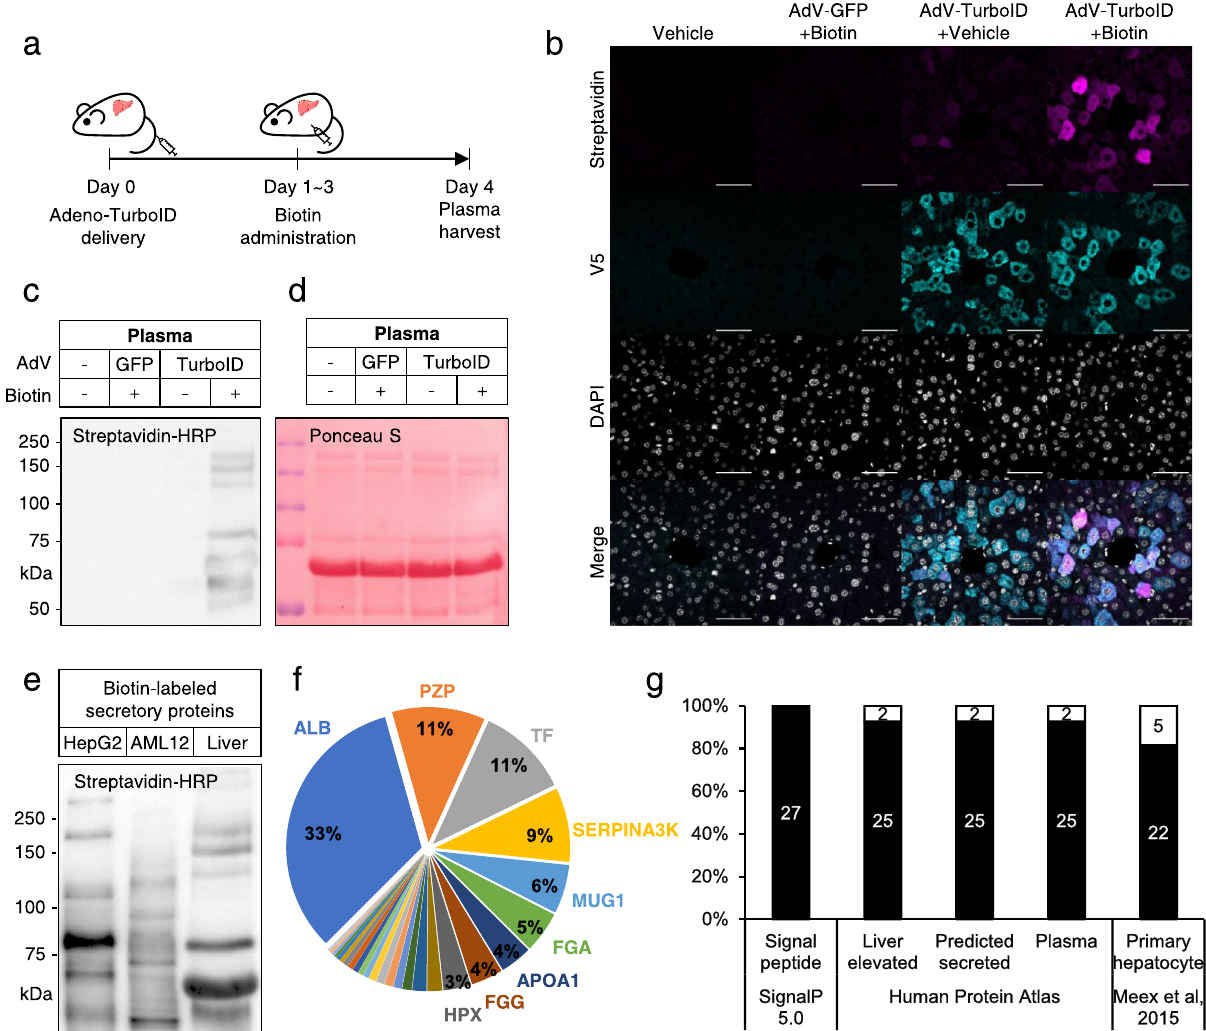
Fig. 3 Identi fi cation of liver-speci fi c secretory proteins in plasma from liver i SLET mice. a Experimental scheme for adenoviral expression of Sec61b-V5- TurboID and biotin labeling in mouse liver tissue. b Immuno fl uorescence imaging of TurboID (Anti-V5) and biotinylated proteins (Streptavidin-Alexa) in liver tissue sections from GFP or Sec61b-V5-TurboID adenovirus (AdV) transduced mice. Scale bars, 50 μ m. These experiments were repeated as biological triplicates with similar results. c , d Streptavidin-HRP detection of biotinylated proteins ( c ) and Ponceau S staining of proteins ( d ) in blood plasma from GFP or Sec61b-V5-TurboID adenovirus (AdV) transduced mice. These experiments were repeated as biological triplicates with similar results. e Biotinylated secretory protein pro fi les generated by Sec61b-V5-TurboID adenovirus in supernatants of hepatocyte cell lines, HepG2 and AML12, and plasma of liver i SLET mice. These experiments were repeated as biological triplicates with similar results. f Relative abundance of biotinylated secretory proteins detected in the plasma of liver i SLET mice in terms of biotinylated spectral counts. ALB, Serum albumin; PZP, Pregnancy zone protein; TF, Serotransferrin; SERPINA3K, Serine protease inhibitor A3k; MUG1, Murinoglobulin-1; FGA, Fibrinogen alpha chain; APOA1, Apolipoprotein A-I; FGG, Fibrinogen gamma chain; HPX, Hemopexin. g Speci fi city analysis for biotinylated proteins with SignalP 5.0, Human Protein Atlas (HPA), and